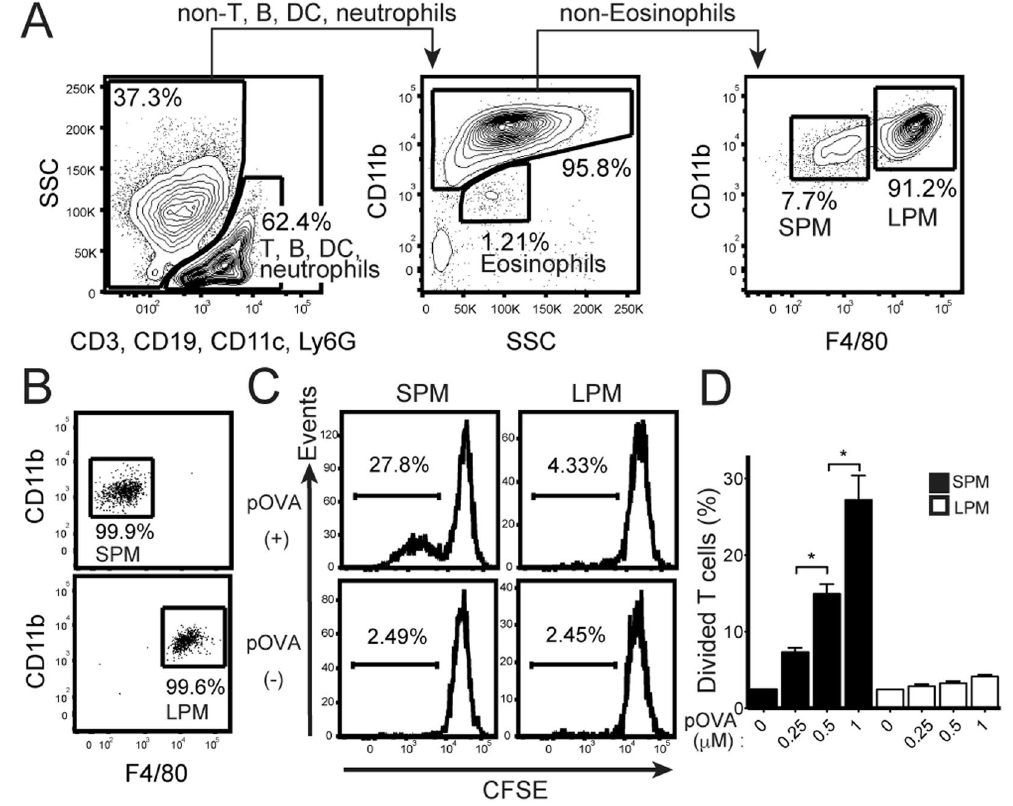
Figure 1. SPMs have the ability to present antigen to naïve CD4 + T cells. ( A ) Gating strategy of SPMs (CD11b + F4/80 − ) and LPMs (CD11b hi F4/80 hi ) in peritoneal cavity cells from naïve C57BL/6 mice. CD3 + T cells, CD19 + B cells, CD11c + dendritic cells (DCs), Ly6G + neutrophils, and CD11b lo SSC hi eosinophils were excluded, and SPMs and LPMs were distinguished. Numbers indicate percentage of the total population in each region. ( B ) Sorting purity of SPMs (upper panel) and LPMs (lower panel). ( C , D ) CD62L hi CD44 dull CD4 + naïve T cells isolated from OT-II Tg mice were labeled with carboxyfluorescein succinimidyl ester (CFSE); and 2 × 10 4 cells were cocultured with same number of SPMs or LPMs isolated from peritoneal cells of naïve mice, in the presence of pOVA at indicated doses. On day 5, the proliferation of CD11b negative-gated T cells was assessed by flow cytometry analysis of CFSE dilution. Histograms show representative data after culture with or without 1 µ M pOVA ( C ). Bar graph shows the average of three wells for each of the indicated pOVA concentrations ( D ); error bars indicate SEM. * P < 0.05. Data is representative of two independent